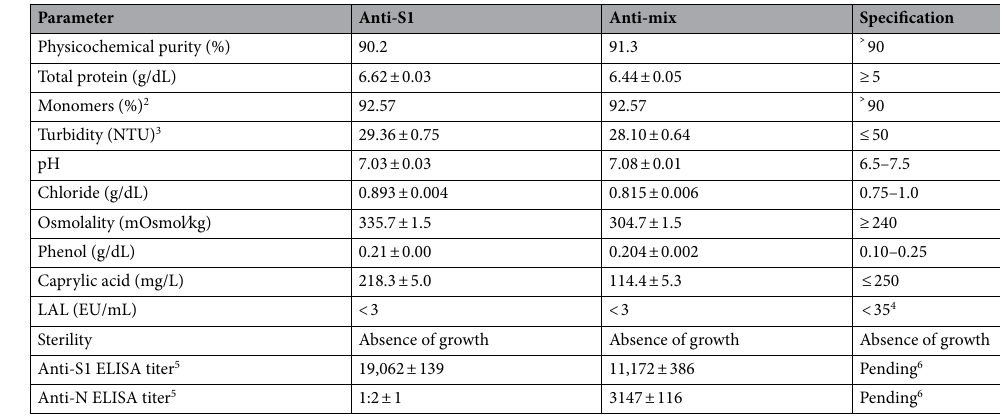
Table 3. Quality control assessment of anti-S1 and anti-Mix immunoglobulin preparations 1 . 1 Formulations were adjusted to a similar protein concentration. 2 Monomer content is expressed as the relative percent of monomeric immunoglobulin proteins as analyzed by size exclusion chromatography. 3 Turbidity is expressed in nephelometric turbidity units (NTU). 4 Endotoxin limit was calculated as the quotient K/M, where K is the threshold pyrogenic dose of endotoxin per kilogram of body weight (5 EU/kg), and M is the maximum total dose administered to a 70 kg-patient for 1 h. Based on our results, the recommended dose for anti-S1 and anti-Mix formulations is 10 mL. Therefore, the acceptable endotoxin limit for this formulation is: (5 EU/kg)/ (10 mL/70 kg) = 35 EU/mL. 5 ELISA titer was calculated as the dilution at which the sample absorbance was equal to three times the absorbance of a normal equine immunoglobulin preparation (NEI) diluted 1:1000. 6 This specification will be established after evaluation of the formulations in a clinical study. Data are expressed as mean ± SD.